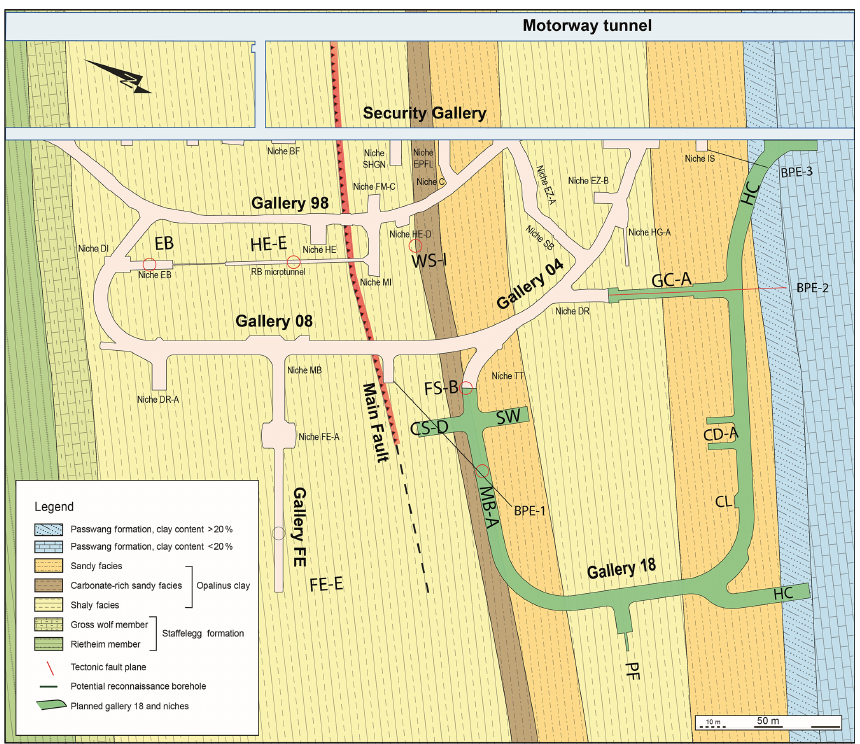
Figure 3. Map of the Mont Terri rock laboratory showing the excavation phases of the laboratory since the year 1996, recently excavated tunnels and niches are marked in green. Three exploration boreholes BPE are included as thin lines, red circles indicate experiments discussed in this paper, acronyms stand for experiments with involvement of BGR (modified after Raselli et al., 2019).